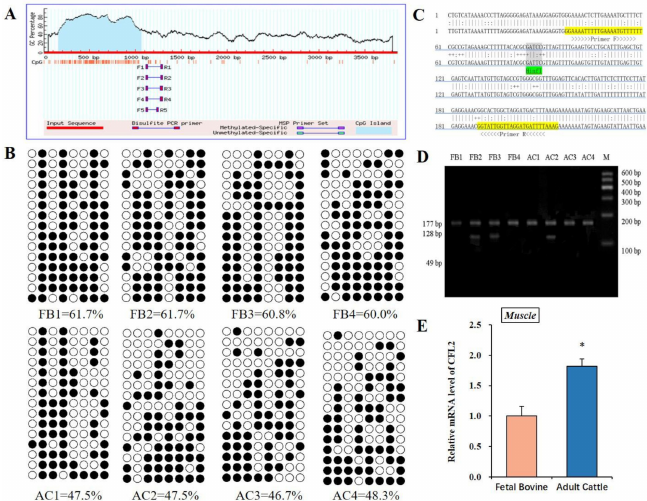
Figure 2. DNA methylation analysis of CFL2 promoter region in muscle tissues. Schematic represen- tation of the proximal promoter region (+1 to − 3850 base pairs) to predict high-GC-content regions of CFL2 gene. In CFL2 gene promoter region, there were 177 bp CFL2 DMR ( A ). BSP assay was used to analyze DNA methylation profiles in FB and AC muscle tissues. There are few rows, one for each of the monoclonal bacterial antibodies; there are 8 columns, meaning 8 CpG islands; black circles, meaning methylated CpG region; and white circles, meaning unmethylated CpG region ( B ). The 177 bp CFL2 DMR contains eight CpG islands, lower strands present bisulfite-converted bases, and yellow highlights and arrows indicate primer sequences using Hin fI (“GANTC”) to cut 4th–5th CpG islands for COBRA assay ( C ). COBRA assay was performed to analyze the DNA methylation patterns in FB and AC muscle tissues, each performed in quadruplicate. M means Marker I ( D ). We further examined the CFL2 gene mRNA levels in FB and AC muscle tissues. Mean data ± SE of n = 3 independent experiments, each performed in quadruplicate, and normalized to GAPDH , (* p < 0.05) ( E